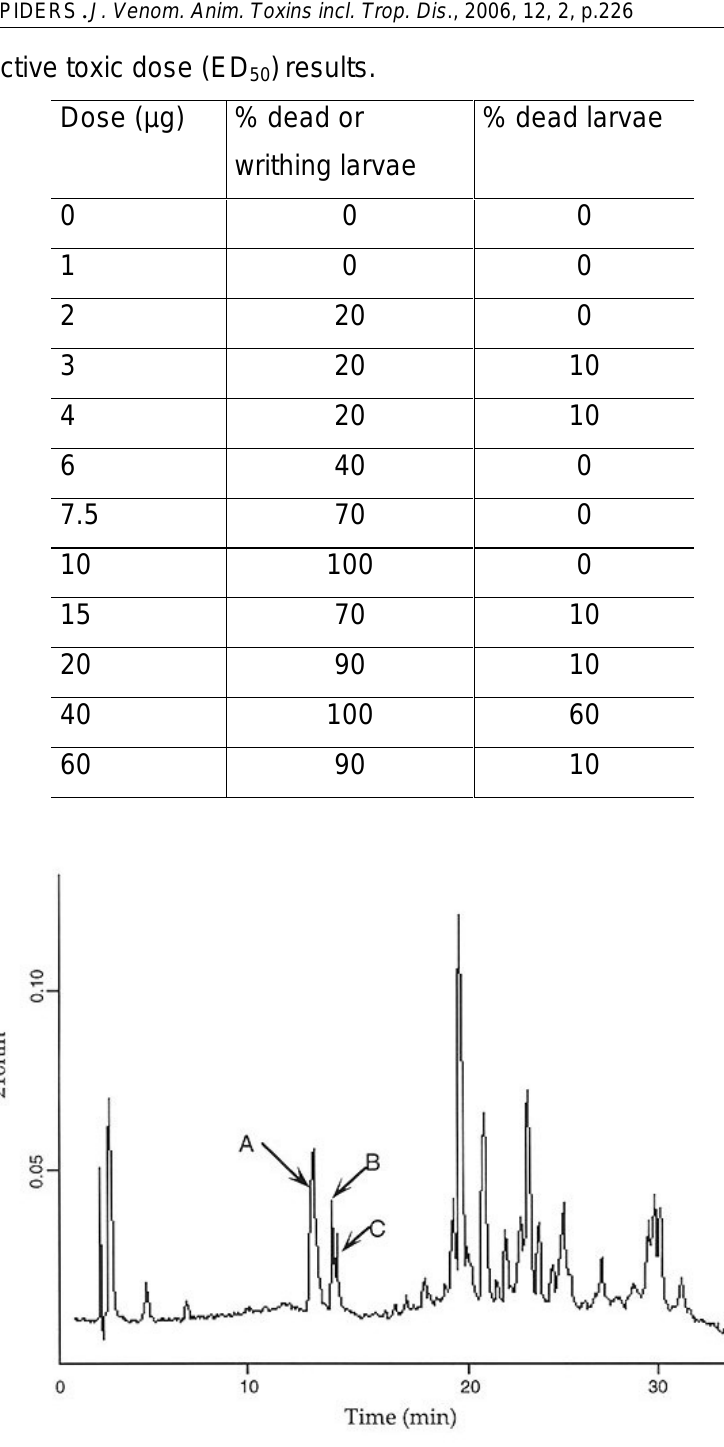
Figure 1: Reversed phase HPLC chromatogram of H. infensa crude venom. The peaks marked A, B and C corresponded to atracotoxins-Hi1a, b and